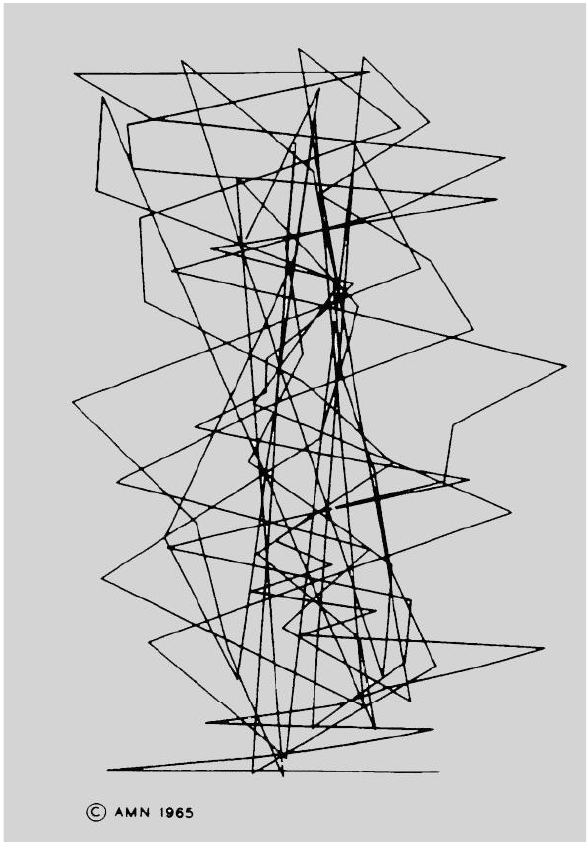
Figure 2 | A. Michael Noll: Gaussian Quadratic. 1963/1965. Credit: A.M. Noll